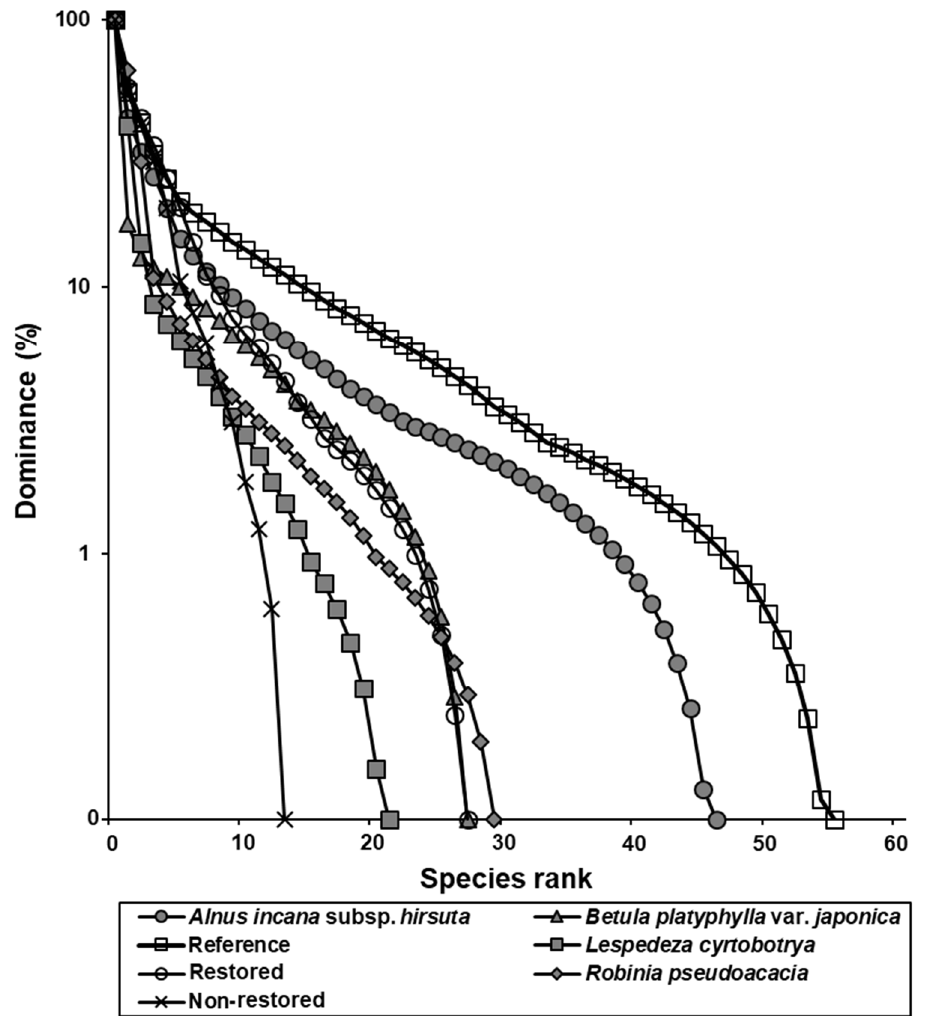
Figure 9. Rank–abundance curves of vegetation including sites restored ecologically (restoration), rehabilitated applying the silvicultural method ( Alnus incana subsp. hirsuta , Betula platyphylla var. japonica , Lespedeza cyrtobotrya , and Robinia pseudoacacia ), and reference stands dominated by Quercus mongolica.